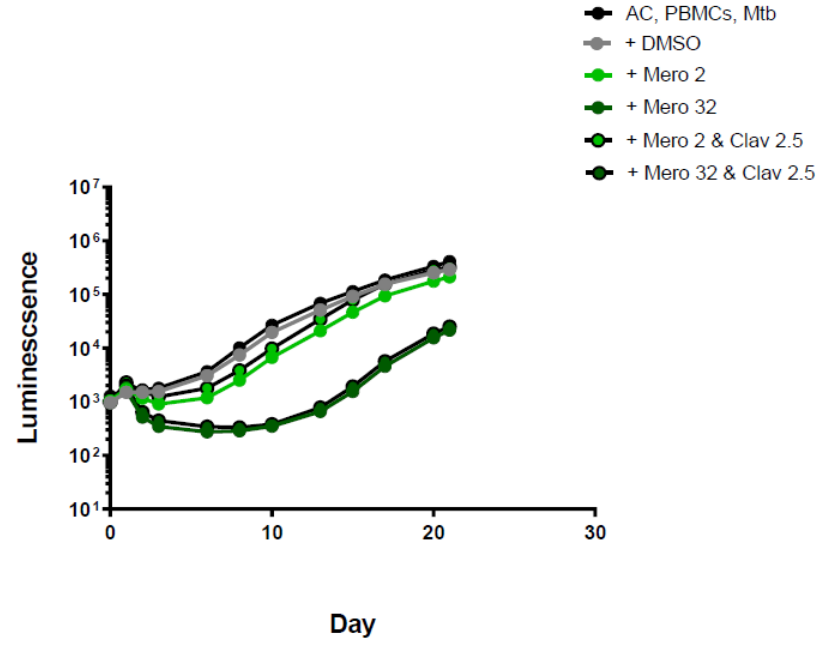
Figure 3. Luminescence detection at different time points for meropenem in TB-infected PMBCs obtained from donor 1. AC: alginate collagen; PMBCs: peripheral blood mononuclear cells; Mtb: Mycobacterium tuberculosis; DMSO: dimethyl sulfoxide; Mero 2: Meropenem 2 mg/L; Mero 32: Meropenem 32 mg/L; Clav 2.5: clavulanic acid 2.5 mg/L.